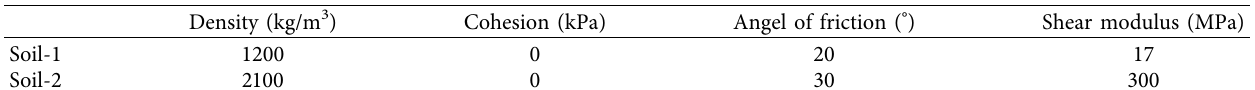
Figure 2: Dimension of the model box and buried pipeline with sensors (mm). (a) Front view. (b) Plan view. (c) Model in the test. Table 3: Soil parameters in model.